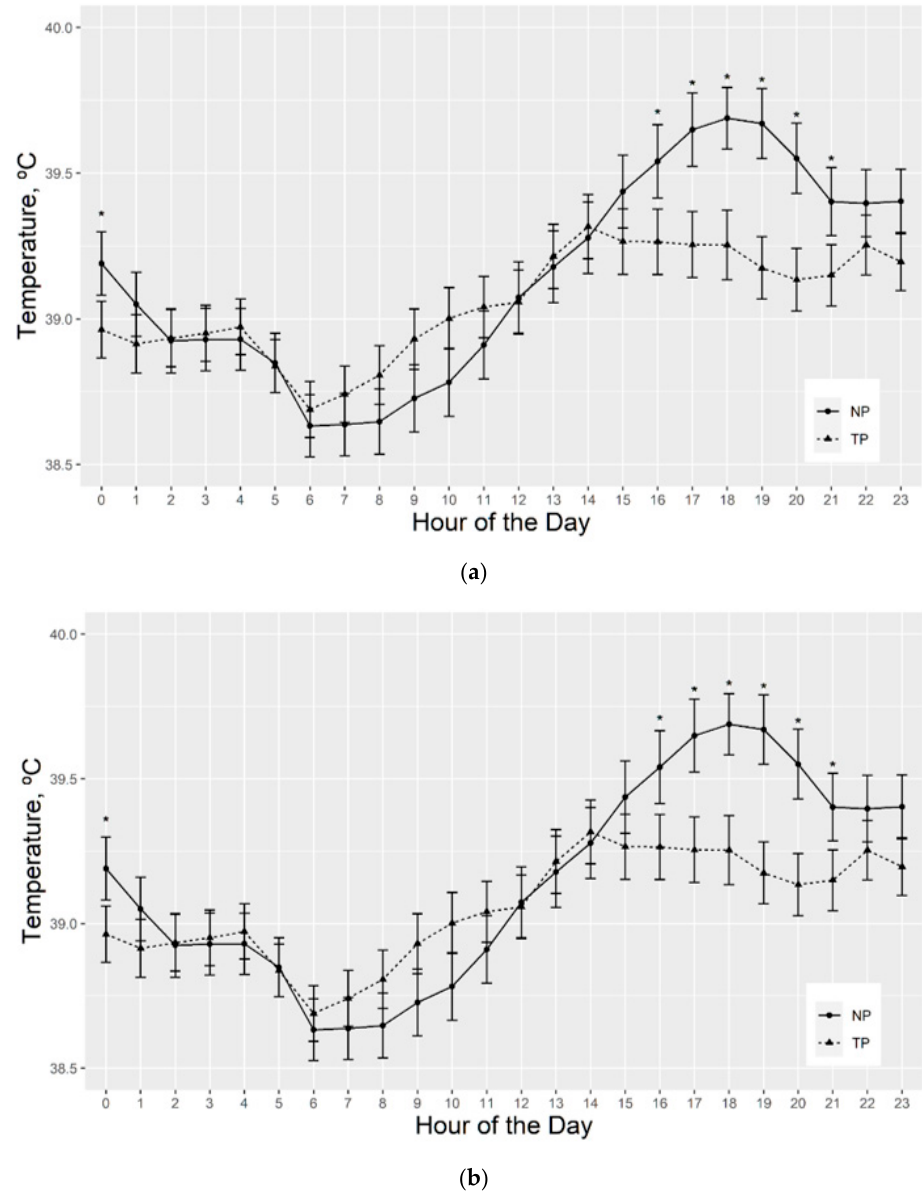
Figure 4. ( a ). Least square means for repeated measures of vaginal temperature of cows grazing toxic fescue pasture with a pond (TP) compared to cows on toxic fescue pasture without a pond (TNP). The last week of the trial, after cows had grazed either toxic or novel fescue for 5 months, cow vaginal temperatures were recorded using iButton thermosensors (Digi-Key, Thief River Falls, MN, USA) in progesterone-free Controlled Internal Drug Releasing Device (CIDR) (Zoetis Parsippany-Troy, NJ, USA). Temperatures were captured every 5 min at a sensitivity of ± 0.5 °C. Six days of temperatures were analyzed to exclude handling bias. Tendencies for significant pond effect on vaginal temperature, by hour of the day, at p ≤ 0.06 are indicated by an asterisk above the error bar. ( b ). Least square means for repeated measures of vaginal temperature of cows grazing toxic fescue pasture with a pond (TP) compared to cows on novel fescue pasture with a pond (NP). The last week of the trial, after cows had grazed either toxic or novel fescue for 5 months, cow vaginal temperatures were recorded using iButton thermosensors (Digi-Key, Thief River Falls, MN, USA) in progesterone-free Controlled Internal Drug Releasing Device (CIDR) (Zoetis Parsippany-Troy, NJ, USA). Temperatures were captured every 5 min at a sensitivity of ± 0.5 °C. Six days of temperatures were analyzed to exclude handling bias. Significant toxic exposure effect on vaginal temperature, by hour at p ≤ 0.05, is indicated by an asterisk over the error bar.